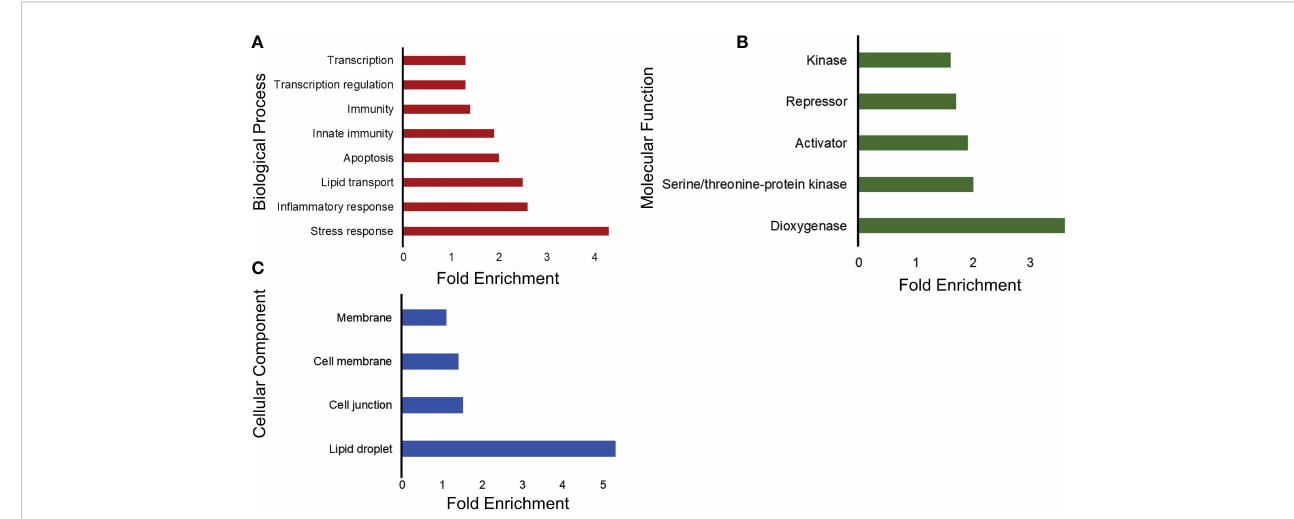
FIGURE 3 Functional annotation analysis of downregulated genes into three main categories using DAVID. (A) Representative bar graphs showing the signi fi cantly enriched genes associated with the biological process. The vertical lines represent the different biological processes involved and the horizontal and the length represent the fold enrichment. (B) Representative bar graphs showing the signi fi cantly enriched genes associated with the activities at the molecular level. The y-axis represents the different molecular functions ordered with the fold enrichment on the x-axis. (C) Representative bar graphs showing the signi fi cantly enriched genes associated with the cellular structures in which a gene functions and is termed as the cellular component. The y-axis represents the different cellular components ordered with the fold enrichment on the x-axis.